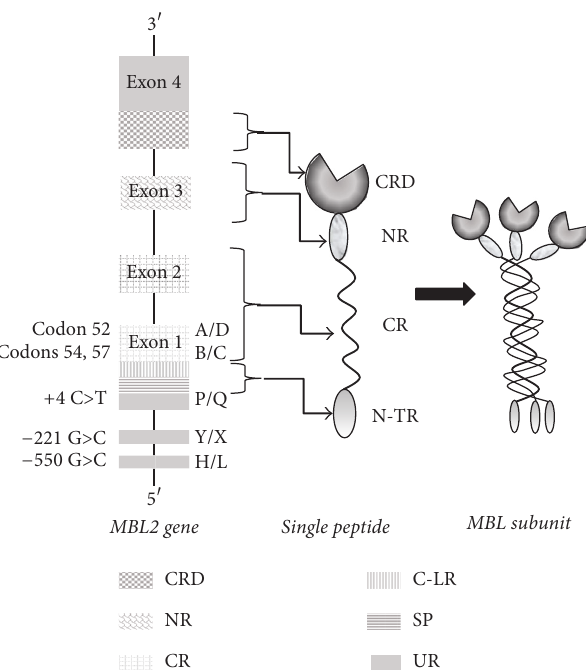
Figure 1: The MBL gene and the MBL structure. The organization of the MBL gene is located at chromosome 10q21. Two promotor polymorphisms at positions − 550 and − 221 are indicated. A third polymorphism is found at position +4. Exon 1 of the gene encodes the untranslated region (UR), the signal peptide (SP), and the cross- linking region (C-LR) of the N-terminal and the first part of the collagenous region (CR) harbouring the base mutations that results in the production of the MBL variants. The second exon encodes the remaining part of the collagenous region (CR) including the disruption of the Gly-X-Y repeat. A third exon encodes the neck region (NR). The last exon encodes the carbohydrate-recognition domain (CRD). The MBL subunit is composed of three single peptides.